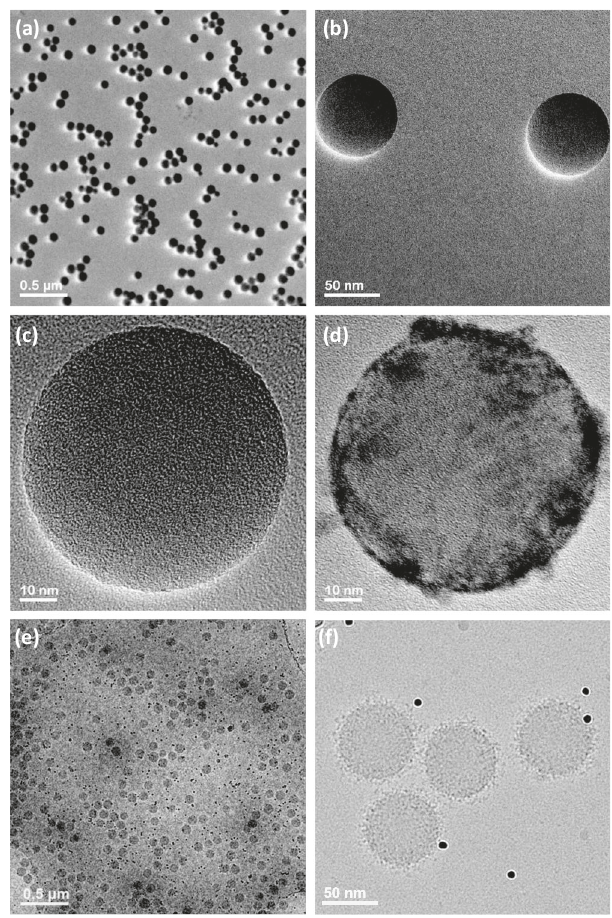
Fig. 2 | Electron microscopy characterization. TEM images of ( a – c ) bare PSNPs, ( d ) protein corona-coated PSNPs that clearly reveal proteins on their surface after incubation with human plasma proteins, ( e ) and ( f ) Cryo-TEM images of protein corona-coated PSNPs obtained with a direct electron detector and phase plate, clearlyshowingthedistributionofproteinsonthesurfaceofthePSNPs(blackdots in the images ( e , f ) are 10nm gold fi ducial markers). The results are representative of three independent